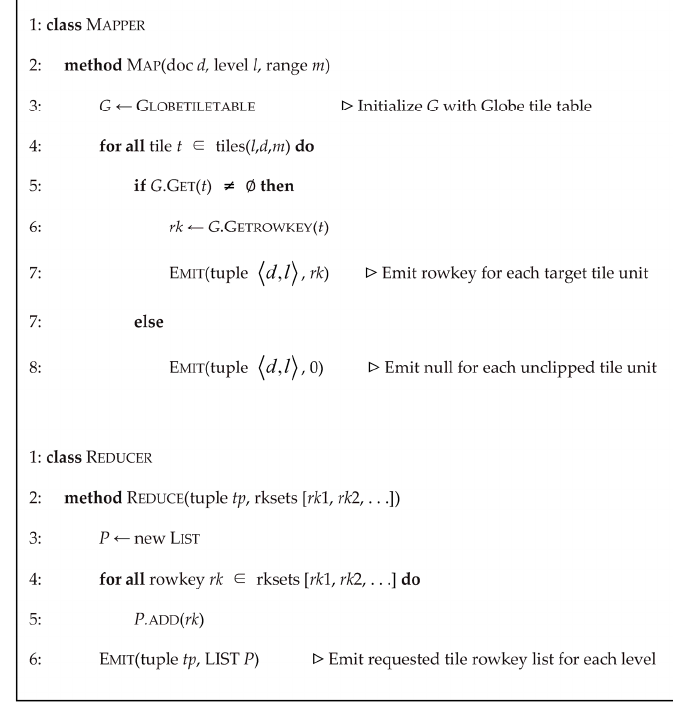
Figure 13. Pseudo-code for the parallel tile query algorithm in MapReduce.